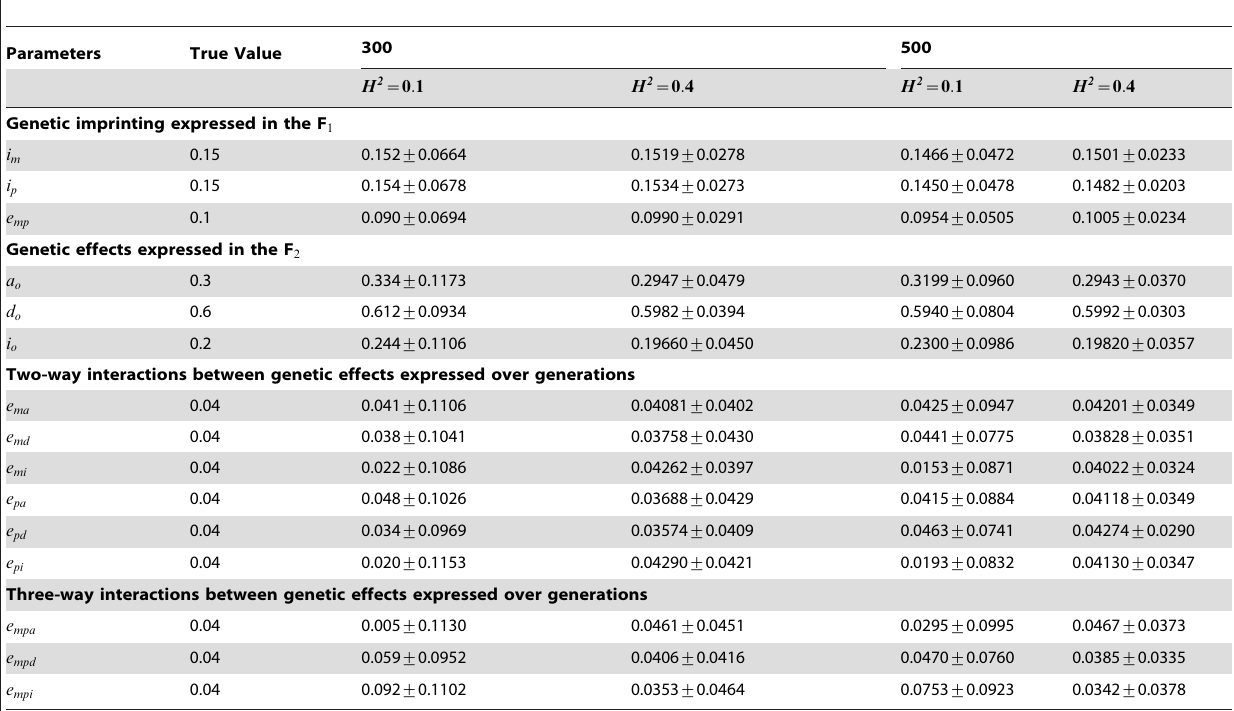
Table 4. Maximum likelihood estimates (and their standard errors) of genetic effect parameters from simulated data under different sample sizes (300 and 500) and heritabilities (0.1 and 0.4).